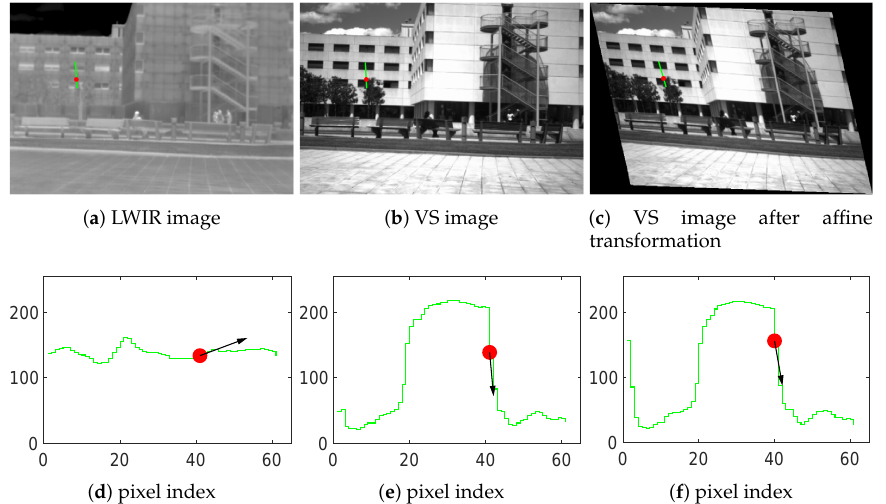
Figure 1. Visualization of nonlinear radiation distortion (NRD) with the red points being the same location in the environment. ( d – f ) show the intensity change near the red points in the image ( a – c ) parallel to the gradient direction from top to down.